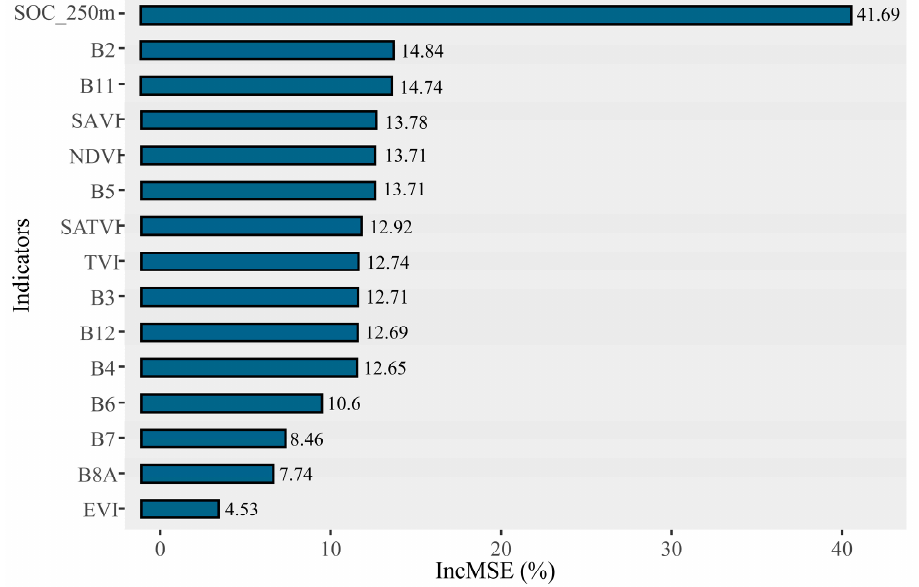
Figure 4. The variable importance projection values distribution in RF.